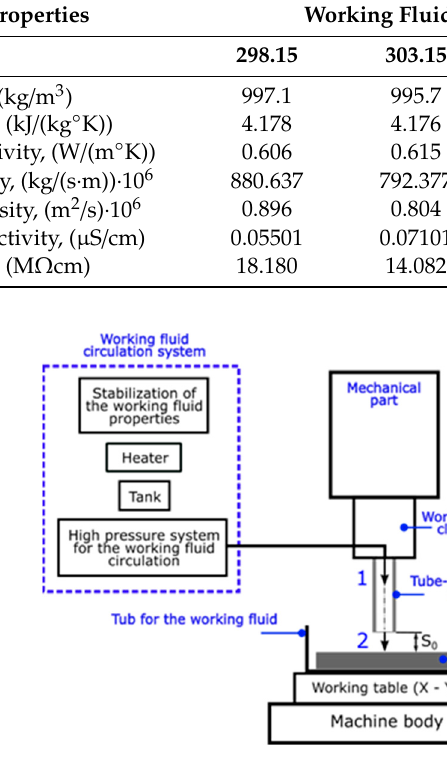
Figure 4. Test stand diagram. Table 7. Process parameters and their levels.